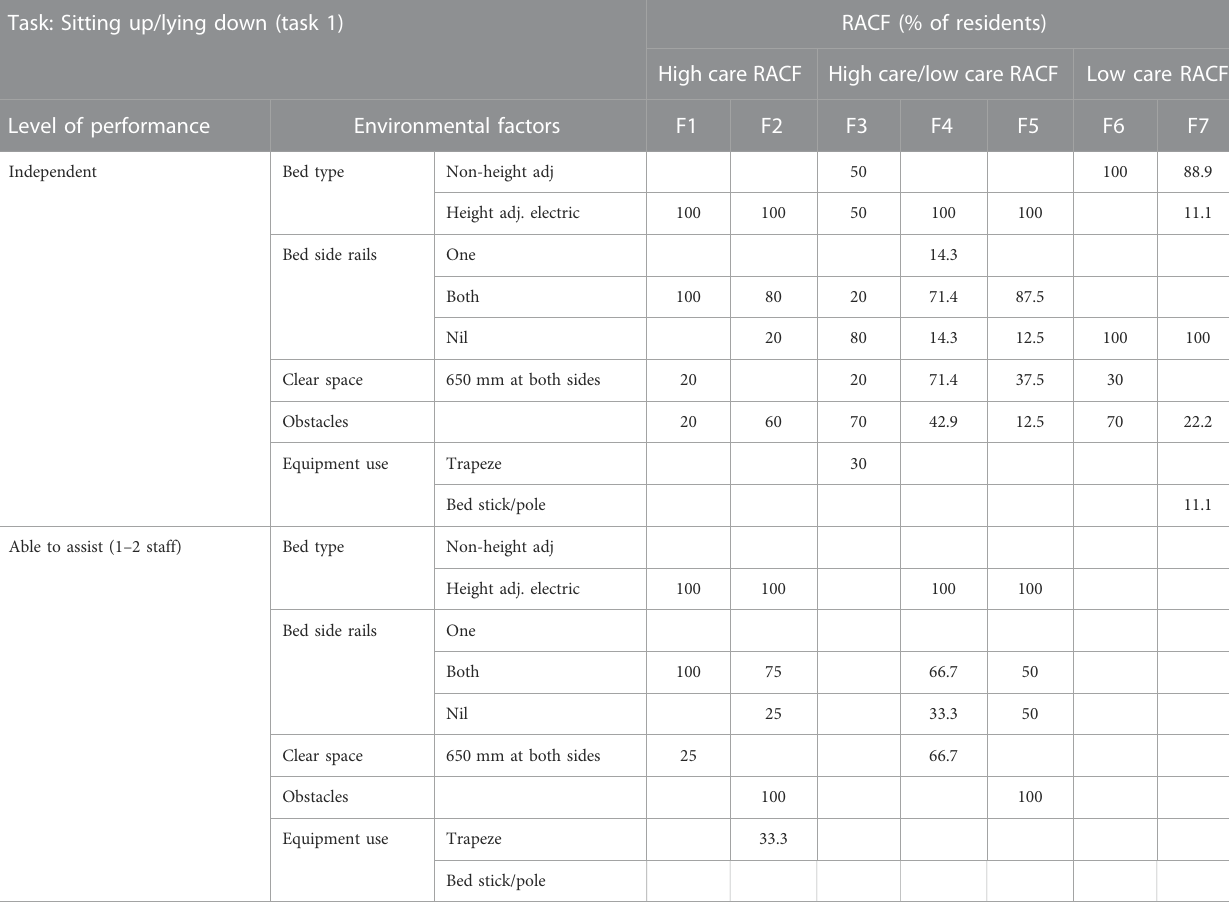
TABLE 2 Summary of the relationship between level of performance with sitting up/lying down (Task 1) and key environmental factors. Task: Sitting up/lying down (task 1)